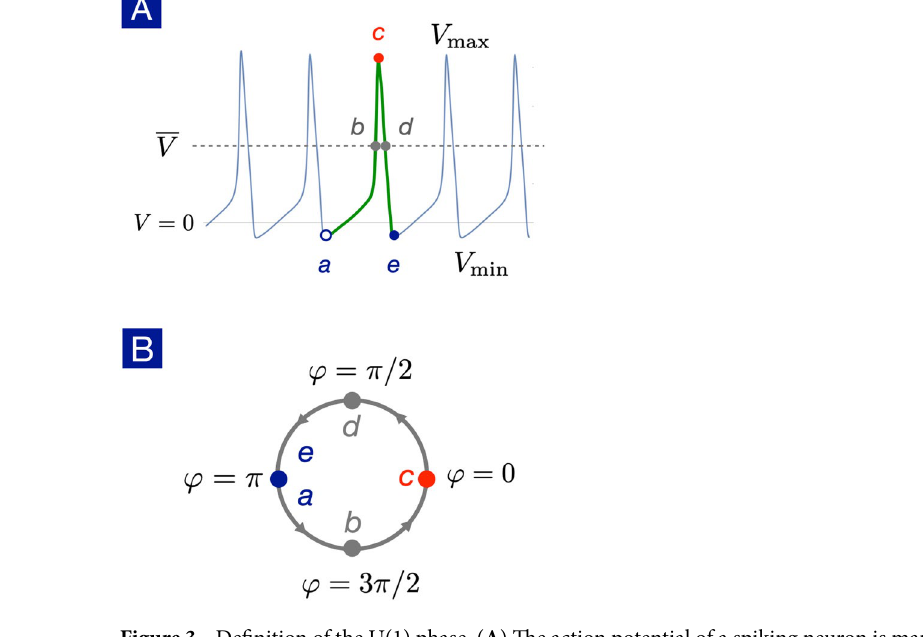
Figure 3. Definition of the U(1) phase. ( A ) The action potential of a spiking neuron is marked by its potential minimum V min (point a , e ), average V (point b , d ) and maximum V max (point c ). ( B ) The points from a to e corresponds to the U(1) phase ϕ = π , 3 π/ 2, 0, π/ 2, π respectively. A complete firing process can thus be viewed as a winding process of �ϕ = 2 π in the phase